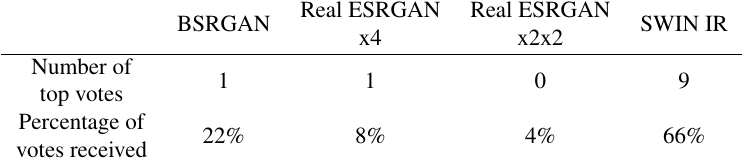
Table 3. The poll-based evaluation of legibility improvement in the typical RWSR results2. We valuated ten different situations. Real BSRGAN